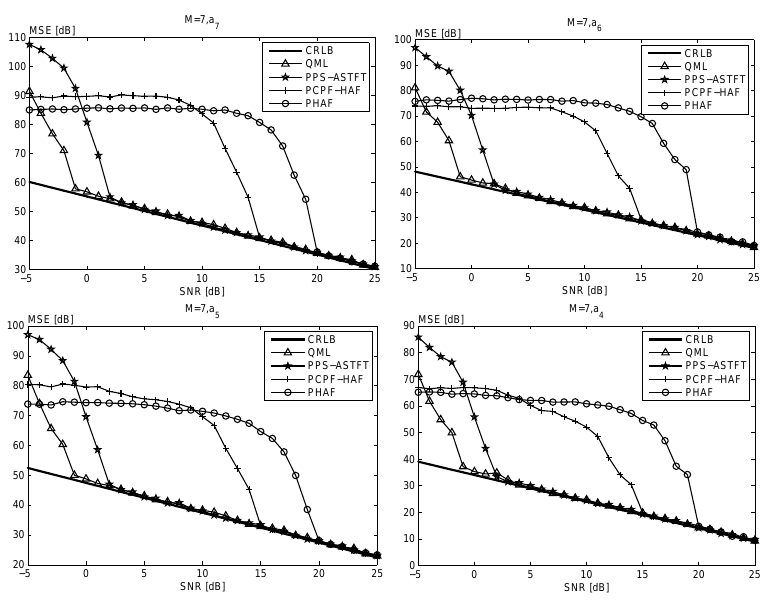
Figure 3. The MSE of the four highest order coefficients of the 7th-order